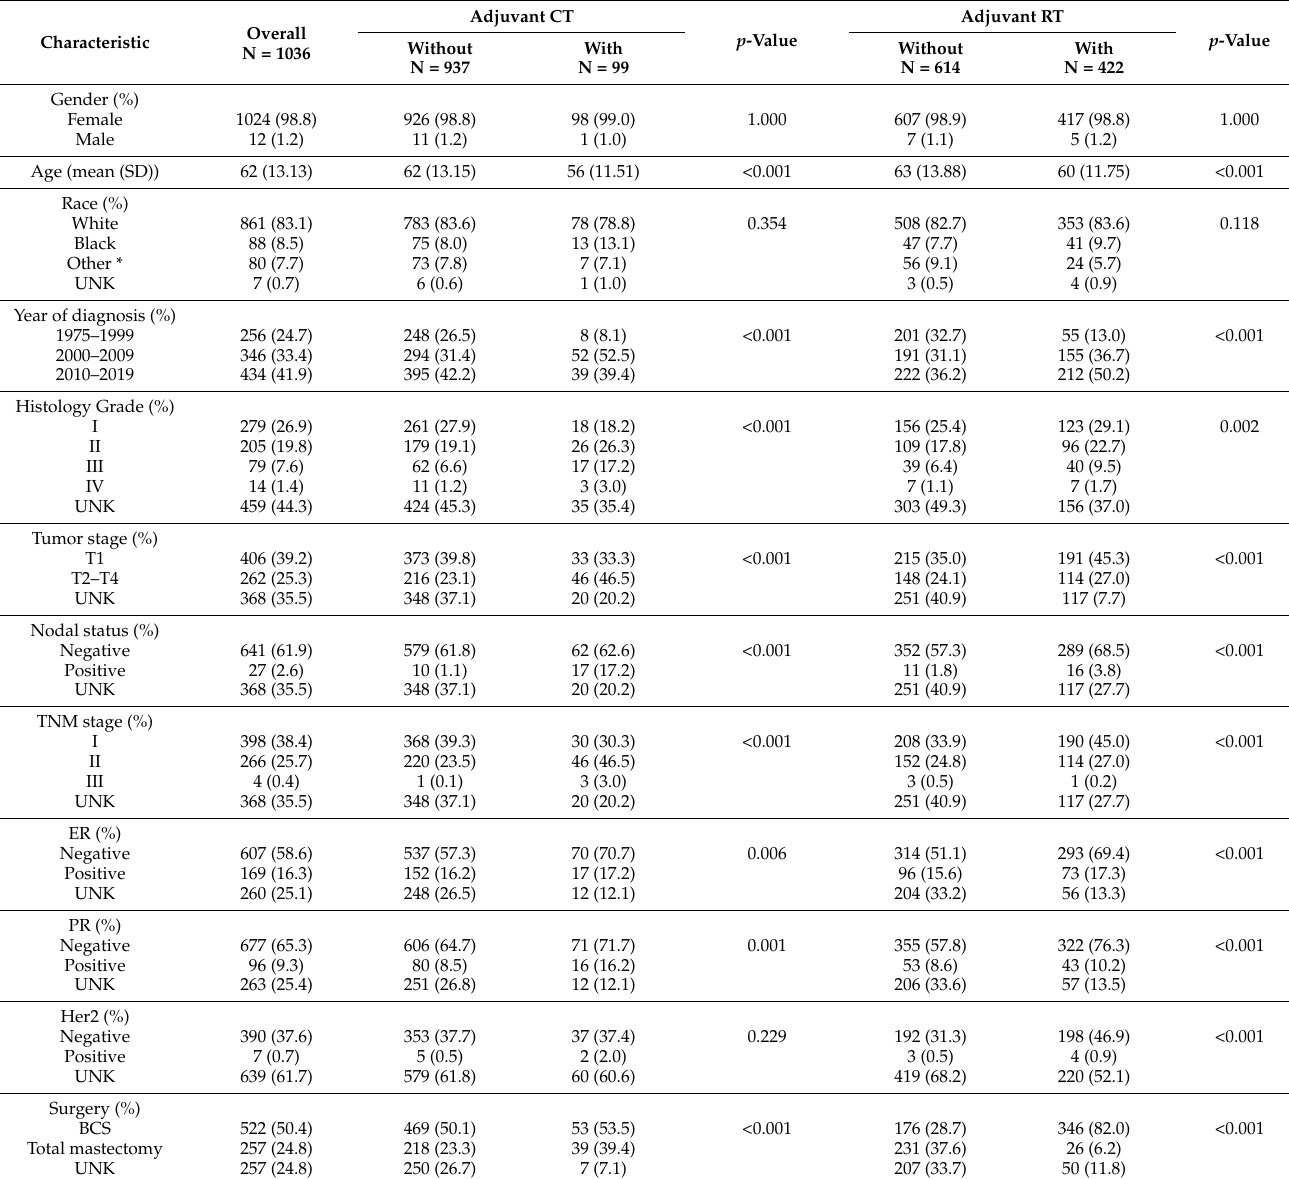
Table 1. Clinic and pathological characteristics of patients with ACC of the breast (N = 1036) stratified by adjuvant